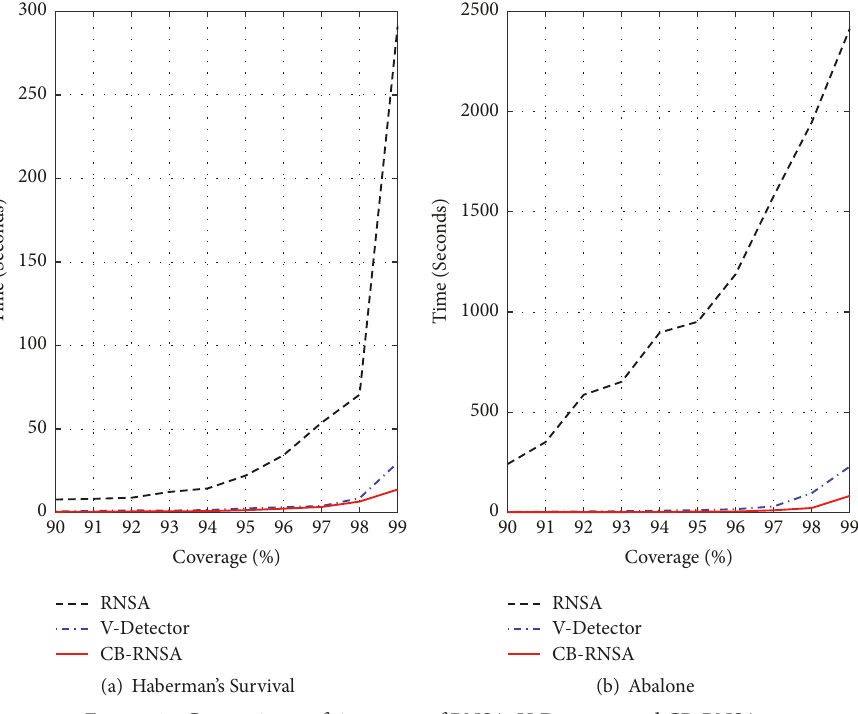
Figure 17: Comparisons of time costs of RNSA, V-Detector, and CB-RNSA.